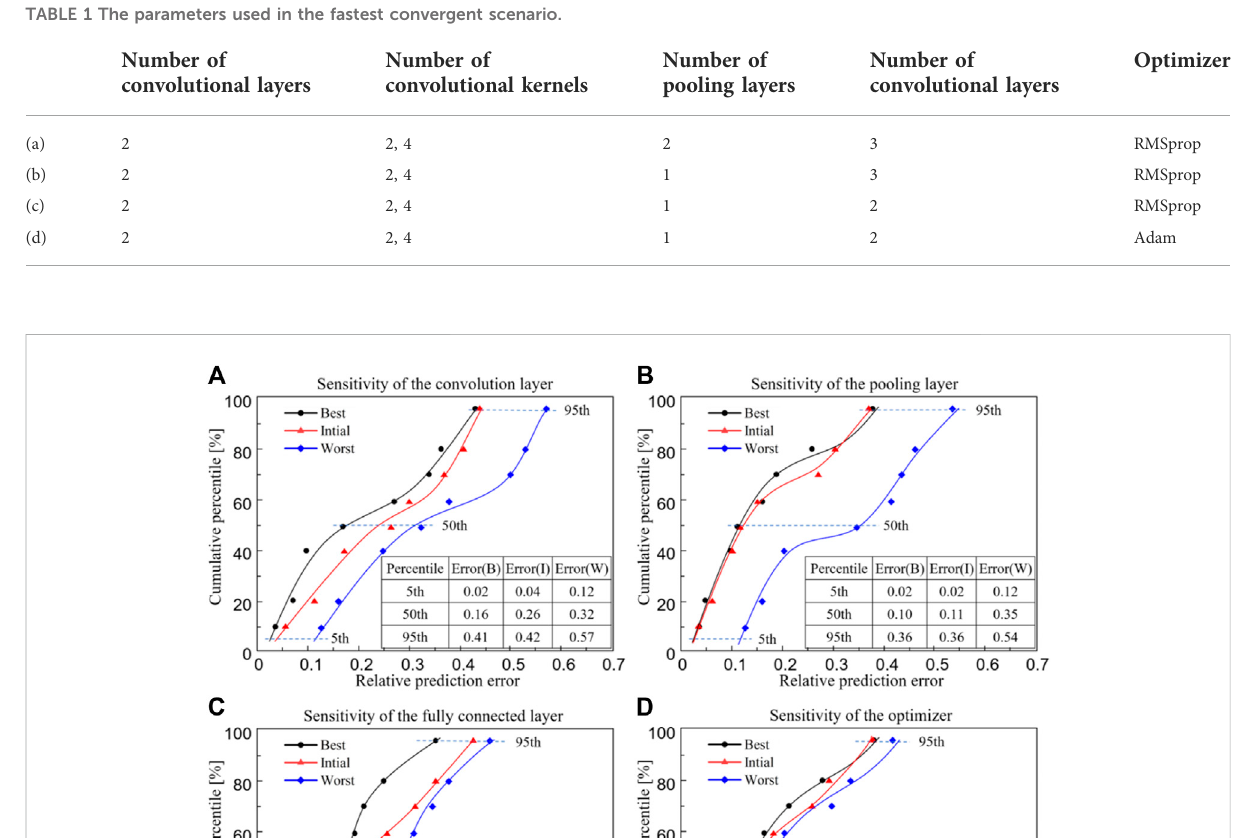
initial prediction and the blue line represents the worst prediction. Since the data are not normally distributed, the 5th, 50th and 95th percentiles are reported. Regarding the 95th percentile of the relative prediction error, it is shown in Figure 7 that when the convolutional layer is modi fi ed, the error can be changed from 0.41 (the best scenario) to 0.57 (the worst scenario) (Figure 7A); when the pooling layer is modi fi ed, the error can be changed from 0.36 to 0.54 (Figure 7B); when the fully connected layer is modi fi ed, the error can be changed from 0.34 to 0.42 (Figure 7C) and when the optimizer is modi fi ed, the error can be changed from 0.36 to 0.41 (Figure 7D). The best parameters corresponding to